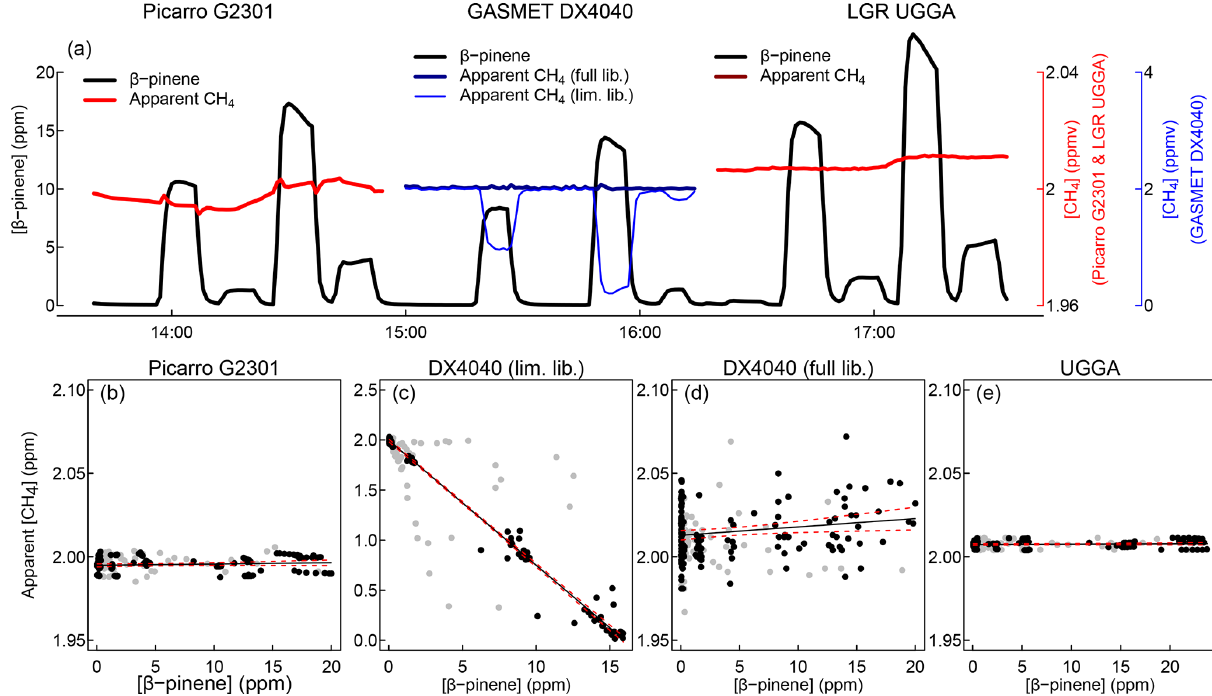
Figure 5. Quantitative measurements of the effect of β -pinene mixing ratios on measured (apparent) methane mixing ratios when analysers were challenged with stepwise changes in the β -pinene mixing ratio. The figure depicts an example of the time course of β -pinene and apparent CH 4 mixing ratios (a) as well as the relationship between β -pinene and the measured CH 4 mixing ratio (b–e) . Note that in (a) , CH 4 concentrations measured by the Gasmet DX4040 analyser are depicted on a different scale (blue) than those measured by the Picarro G2301 and LGR UGGA analysers (red). Black lines in panels (b) – (e) indicate linear regressions, dashed red lines the 95% confidence interval of these regressions. Data points that occurred after rapid changes in the β -pinene mixing ratio and that were therefore excluded from the regression analysis are depicted in grey. Table 4. Estimated impact of VOC interferences on methane flux measurements based on literature data of CH 4 and VOC fluxes. Chamber type Soil chamber (upland) Stem